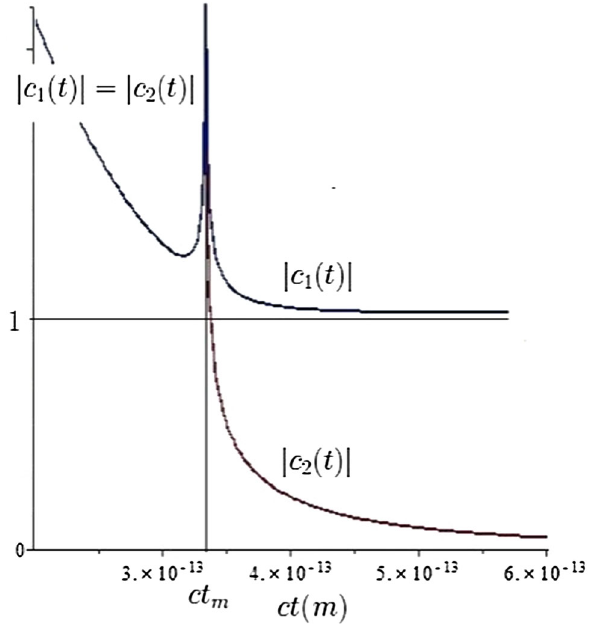
Fig. 2 The function n ( t 0 , t ) versus ct in the domain t m < t < 14 t m Fig. 1 The functions | c 1 ( t ) | and | c 2 ( t ) | versus ct for a light particle for m = m e and: t 0 = 2 . 4 t m (1), t 0 = 2 . 6 t m (2), t 0 = 2 . 8 t m (3), ∼ 1 . 110 − 21 s . The having the electron mass, m = m e , for which t m t 0 = 3 t m (4), t 0 = 3 . 2 t m e < t < 1 . 8 t plotting domain is 0 . 6 t m m e e